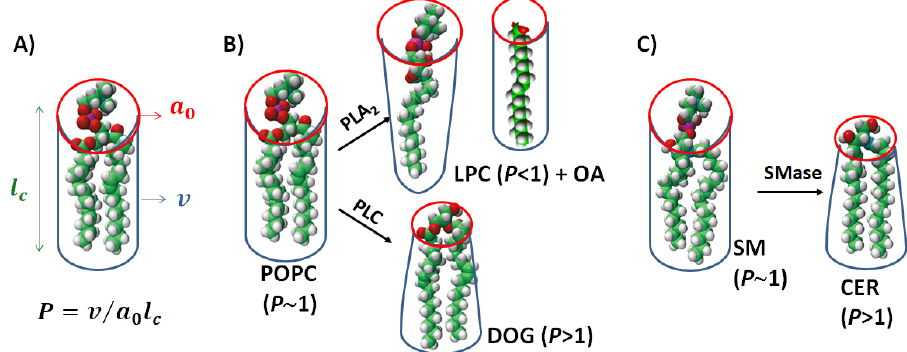
Figure 1. Schematic representation of lipid shapes of phospholipase substrates and products. ( A ) A description of packing parameter construction from the effective shapes of lipid molecules; ( B ) 1 2-dioleoyl-sn-glycero-3-phosphocholine (POPC) can be hydrolyzed by Phospholipase A 2 (PLA 2 ) to 1-oleoyl-2-hydroxy-sn-glycero-3-phosphocholine (LPC) and oleic acid (OA) or can be a substrate for Phospholipase C and be converted to 1-2-dioleoyl-sn-glycerol (DOG). ( C ) N-palmitoyl-D-erythro-sphingosylphosphorylcholine (SM) can be converted to N-palmitoyl-D-erythro-sphingosine (CER) by Sphingomyelinase (SMase). The figure highlights the molecular shapes of the lipids. POPC and SM have a large polar group and two acyl chains, giving a critical parameter ( P ) value close to 1 and forming planar bilayers. DOG and CER, which have small polar headgroups, are inverted-cone- shaped lipids with P > 1, promoting negative-curved structures. LPC has a large headgroup and a single acyl chain and is cone-shaped, showing P < 1 and stabilizing positive-curved structures.